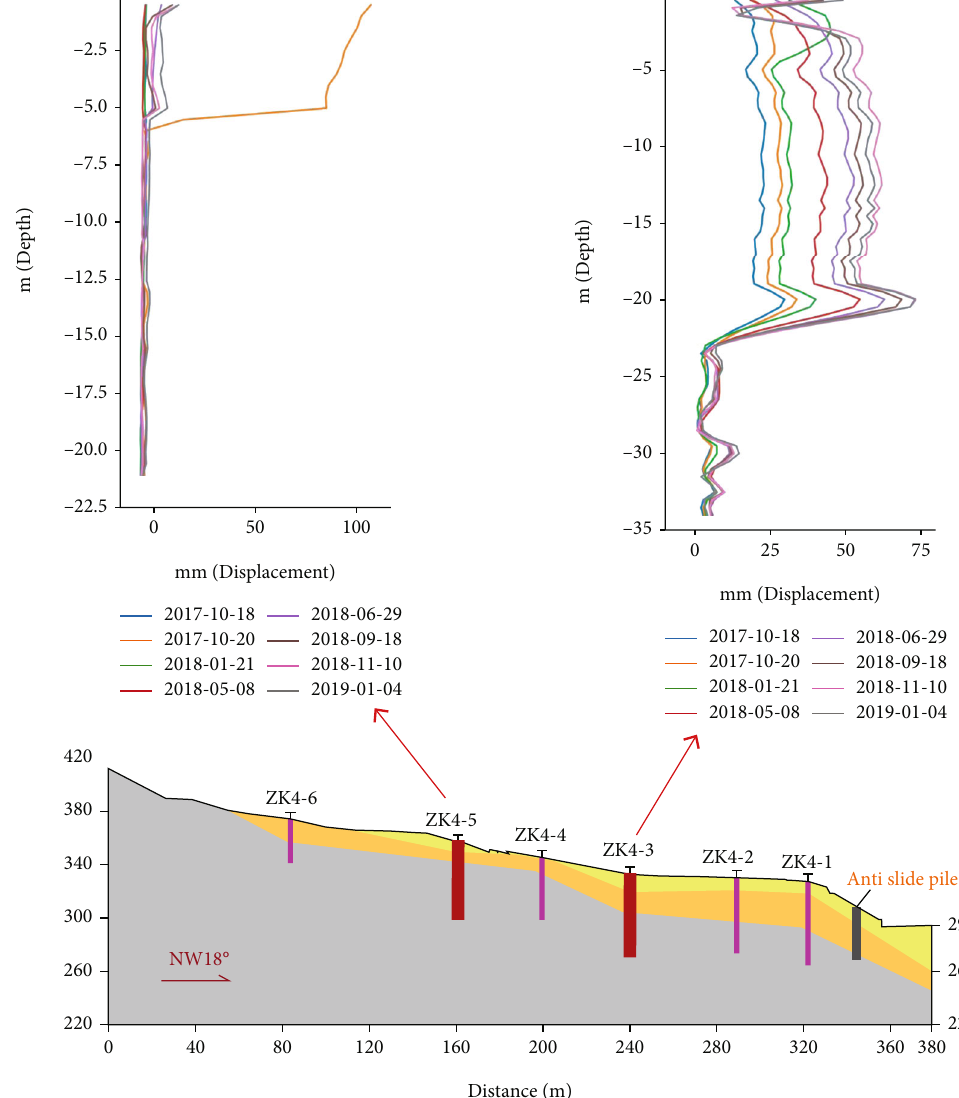
Figure 13: Cumulative displacement-depth curves of ZK4-3 and ZK4-5 boreholes.